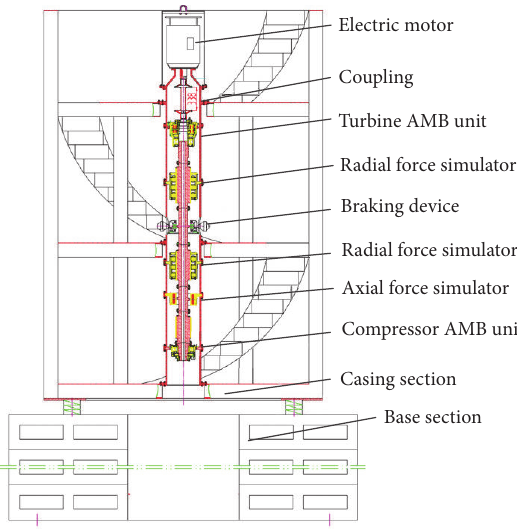
Figure 2: The underground parts of the full scale test